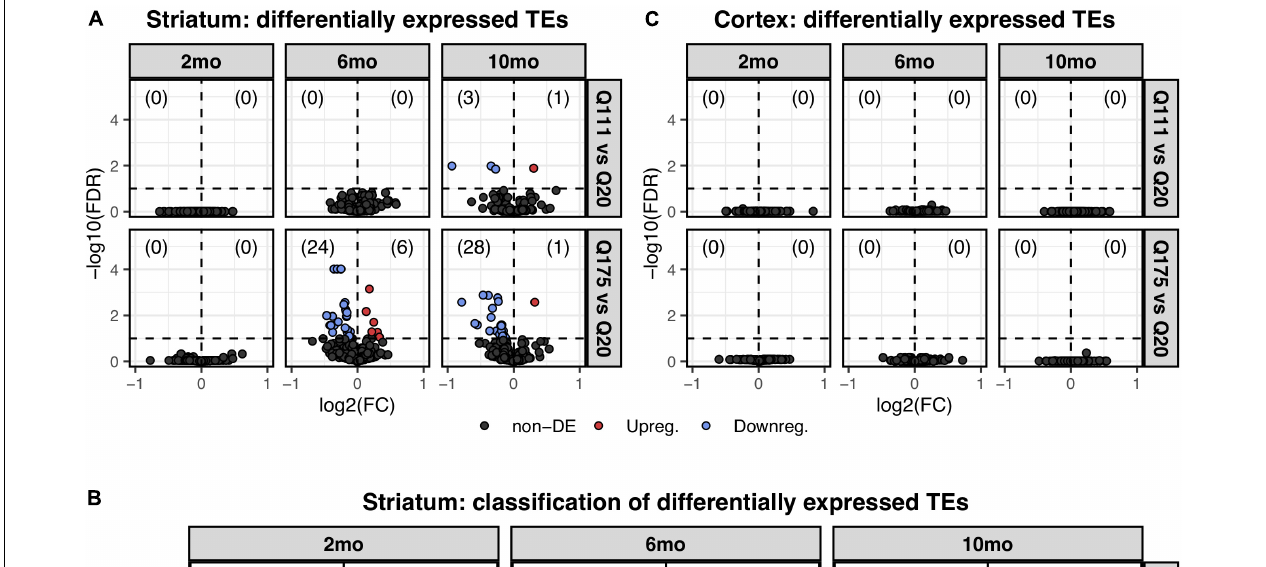
FIGURE 1 | Differentially expressed TEs. (A) Volcano plot showing the murine TE consensus sequences differentially expressed in the striatum of 2-, 6-, and 10-mo mice in Q111 and Q175 genotypes compared to control (Q20). Blue color indicates the TE consensus sequences that result downregulated in each tested comparison (Q111 vs. Q20 and Q175 vs. Q20), red indicates the upregulated TE consensus sequences whereas in black are depicted the TE consensus sequences that do not result differentially expressed (non-DE). Each group is composed by 8 biological replicates ( n = 8). (B) Bar plot reporting the number of differentially expressed TE consensus sequences for each differentially expressed TE subfamily. L1 A , Gf and Tf are classified as “young L1.” (C) Differentially expressed TEs in the cortex of 2-, 6-, and 10-mo mice in Q111 and Q175 genotypes compared to control (Q20). Each group is composed by 8 biological replicates ( n = 8).